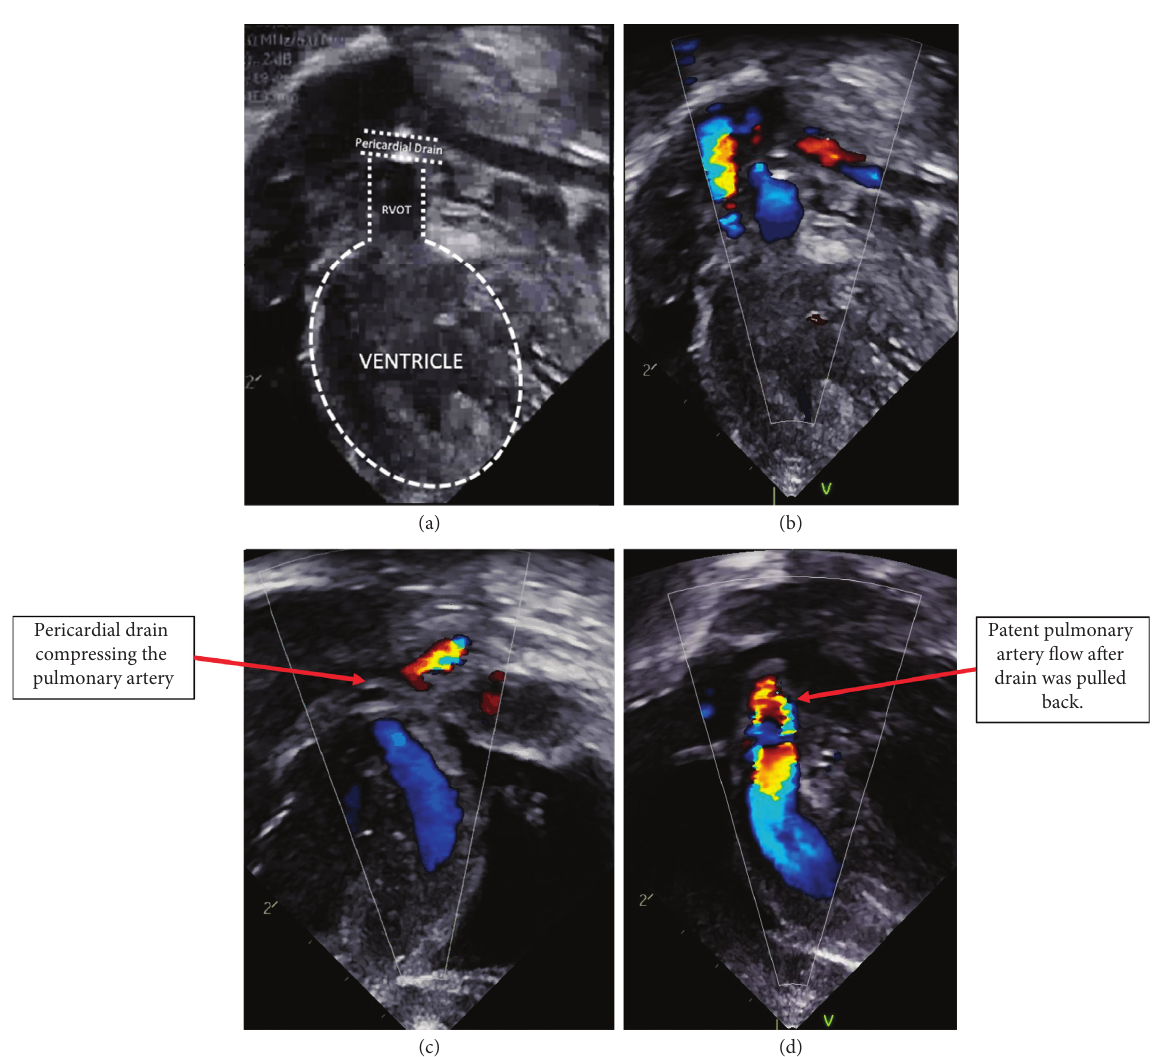
Figure 1: Echocardiogram on the day of the procedure demonstrating a large pericardial effusion. (a) Diagram of the echocardiographic view of the right ventricle and the pulmonary artery used to determine the compression caused by the drain. (b, c) Color Doppler echocardiogram, with and without labels, of the flow obstruction in the pulmonary artery, evident by no blood flow (color) seen distal to the drain. (d) There is improvement of the pulmonary artery flow after the drain was retracted, showing blood flow (color) along all the pulmonary artery, when compared with prior